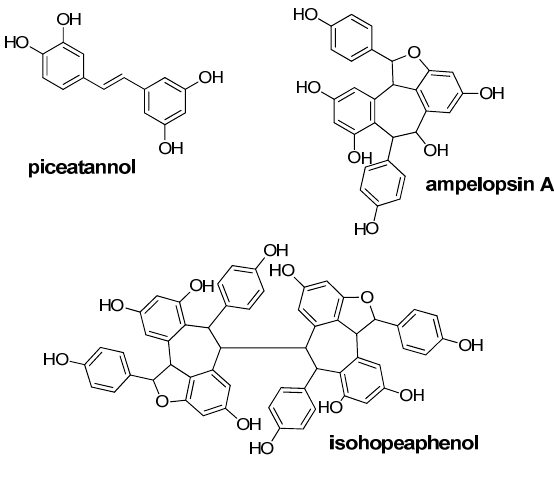
Figure 2. Inhibition and destabilization of α‐ synuclein fibrils by stilbenes: ( a ) α‐ synuclein (70 μ M) was incubated for 4 days at 37 °C in a 20 mM Na 2 HPO 4 /NaH 2 PO 4 140 mM Tris buffer, pH 7.4 in a 96 ‐ well plate with piceatannol (0, 100, and 200 μ M); ( b ) stilbene screening at 100 μ M; ( c ) piceatannol (0, 100, and 200 μ M) was added to previously aggregated fibrils in the aforementioned conditions for 4 days. Data are expressed as mean ± SD of three independent experiments. Results are expressed as mean ± SD* p < 0.05 versus control